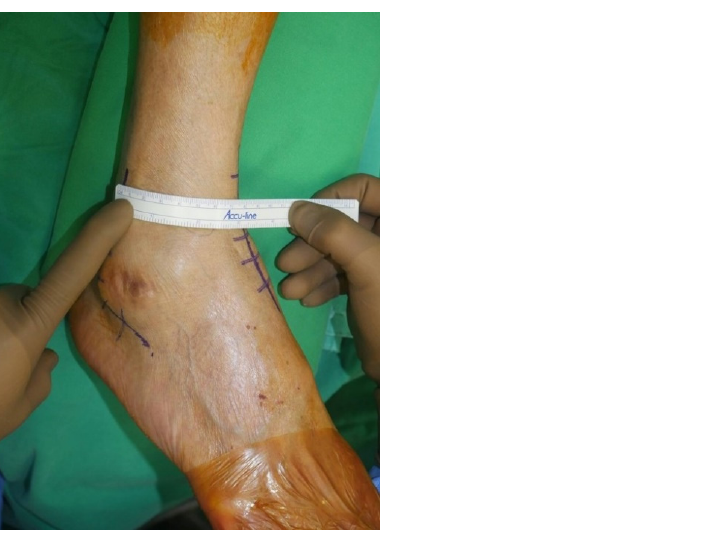
Figure 4. The cartilage and subchondral bone of the tibiotalar joint was removed using curettes, osteotomes, and burrs through the lateral ankle joint.